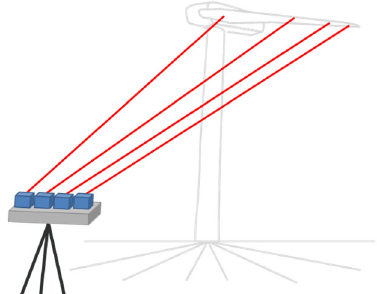
Figure 5. Conceptual design of the fan-shaped distance meter system on a wind turbine